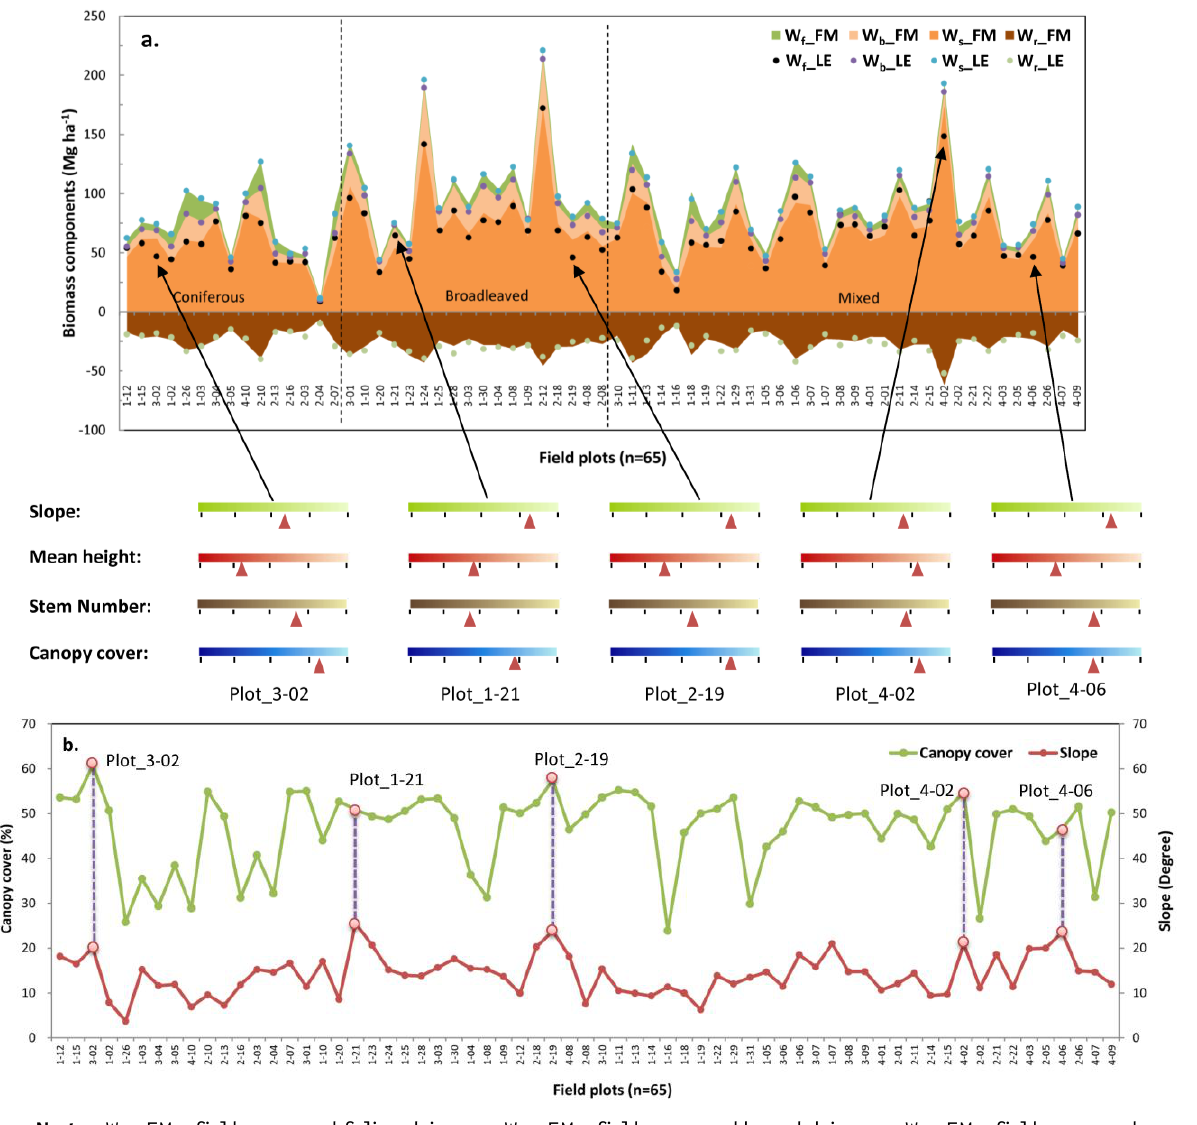
biomass. Five plots with the largest bias are pointed out, and levels of the topographic ( i.e. , slope) and vegetation condition ( i.e. , mean height, stem number and canopy density) factors are marked (by red triangle) within each color ramp bar, showing where the values are within the scaled range of all 65